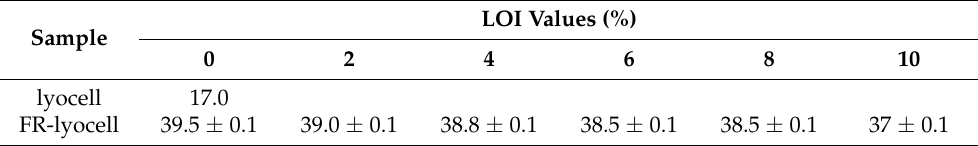
Table 4. LOI values of the samples with different washing cycles.